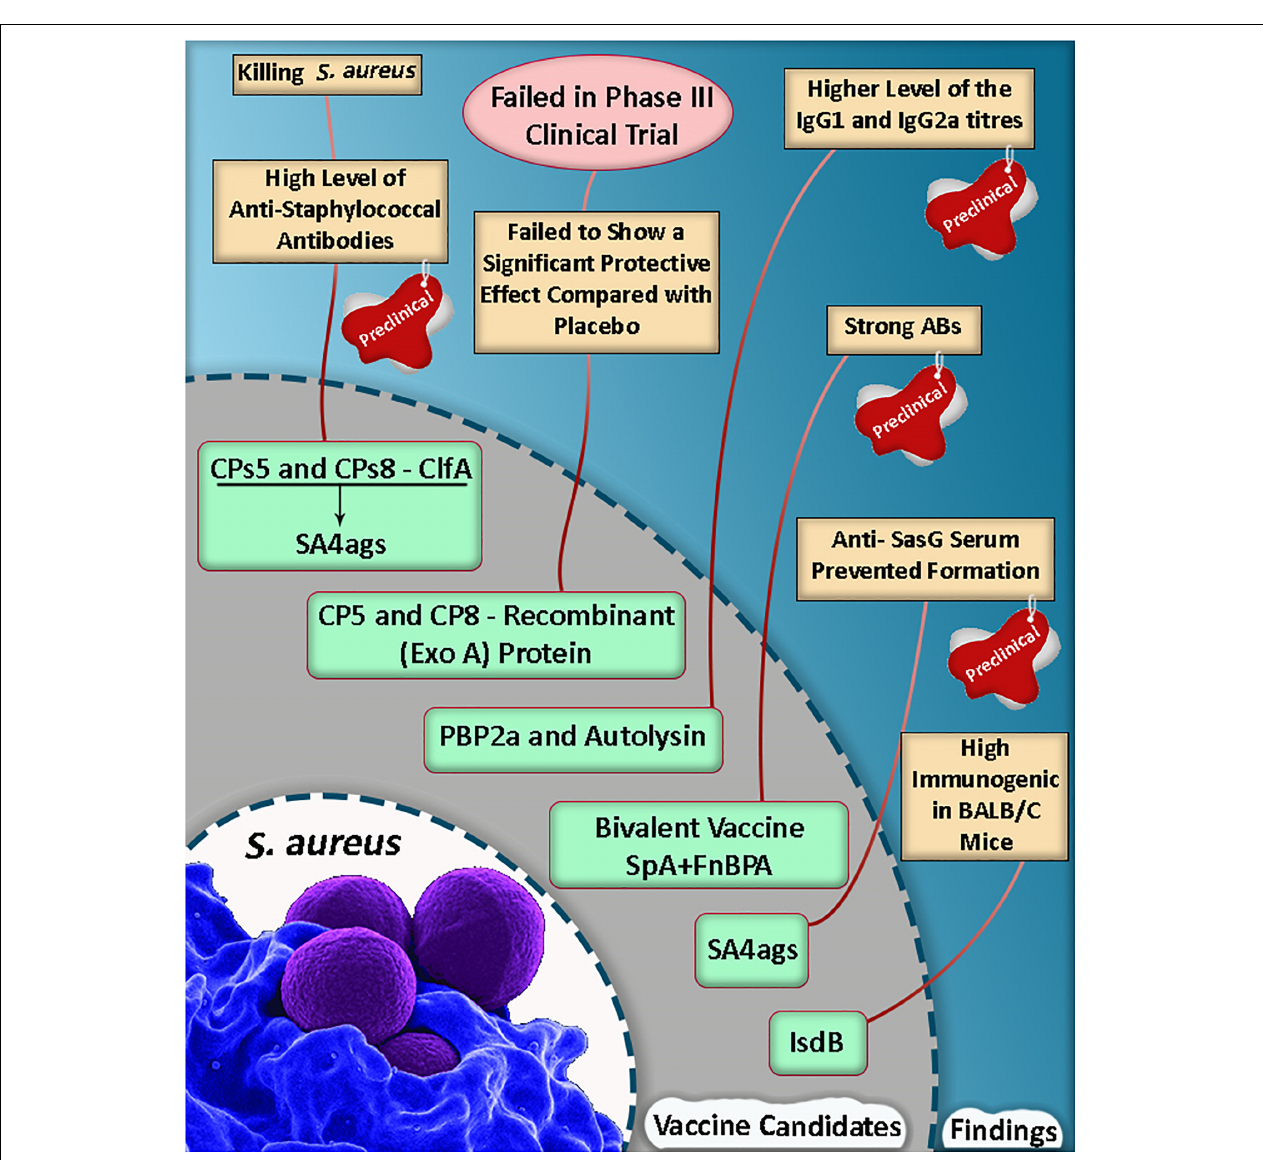
FIGURE 1 | A summary of vaccine candidate development in Staphylococcus aureus (Shinefield et al., 2002; Kuklin et al., 2006; Fowler et al., 2013; Haghighat et al., 2017; Dupont et al., 2018; Yang et al., 2018).